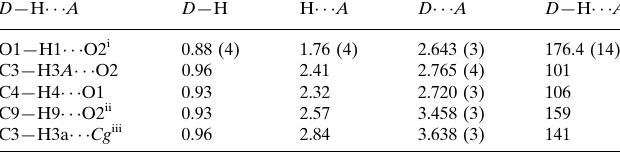
Hydrogen-bond geometry (A˚ , (cid:2)